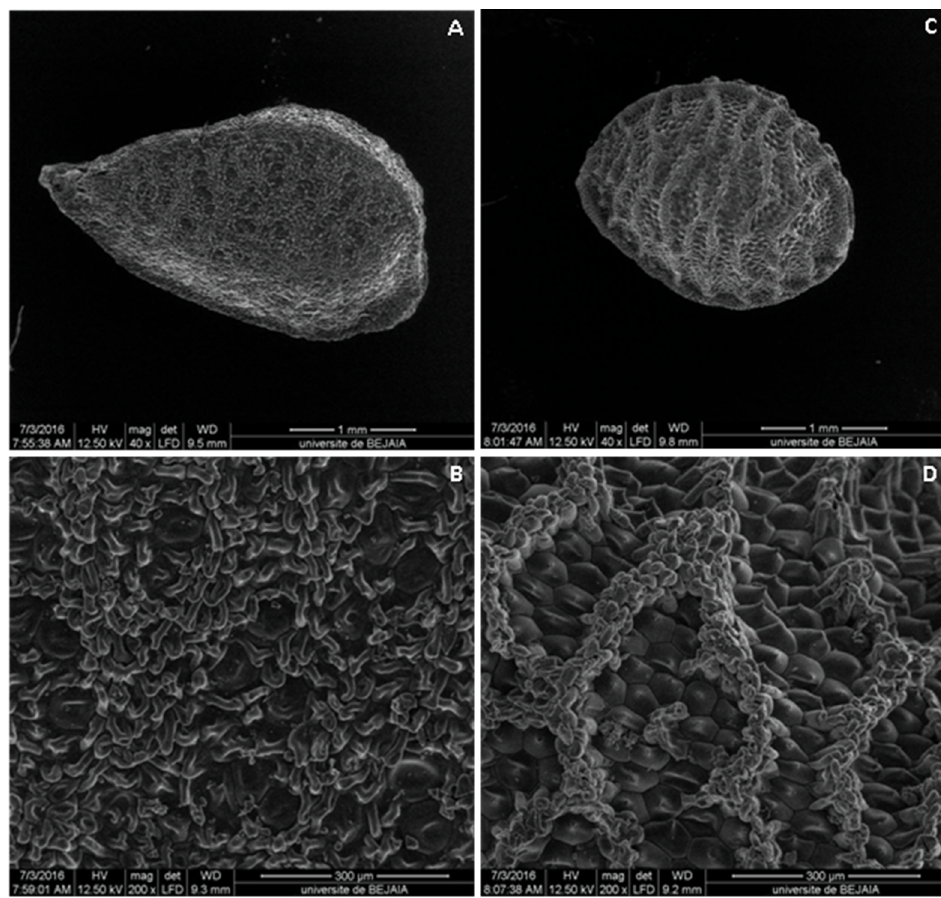
Figure 2. Scanning electron microscopy of seed surfaces. ( A ) General view of Nigella sativa L. seed; ( B ) closer view of Nigella sativa L. seed coat ornamentation, columellated and uncolumellated testa cells; ( C ) general view of Nigella damascena L. seed; ( D ) closer view of Nigella damascena L. seed coat ornamentation, cells of lumen and muri.